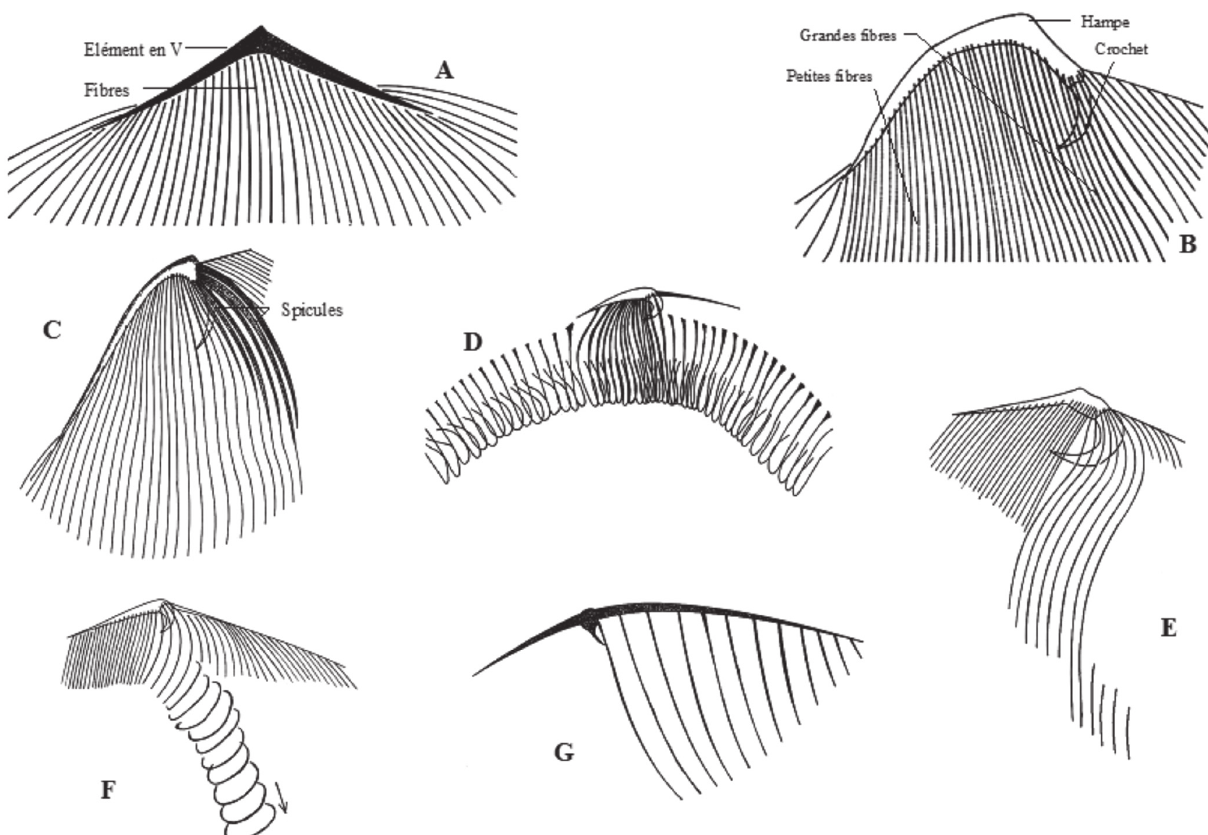
Figure 11. – Cytosquelette des genres représentatifs de la famille des Radiophryida (d’après de Puytorac et Dragesco, 1969, sauf D). A : Radiophrya ; B : Metaradiophrya ; C : Cheissinophrya ; D : Dicoelophrya ; E : Metaracoelophrya ; F : Coelophrya ; G : Paracoelophrya